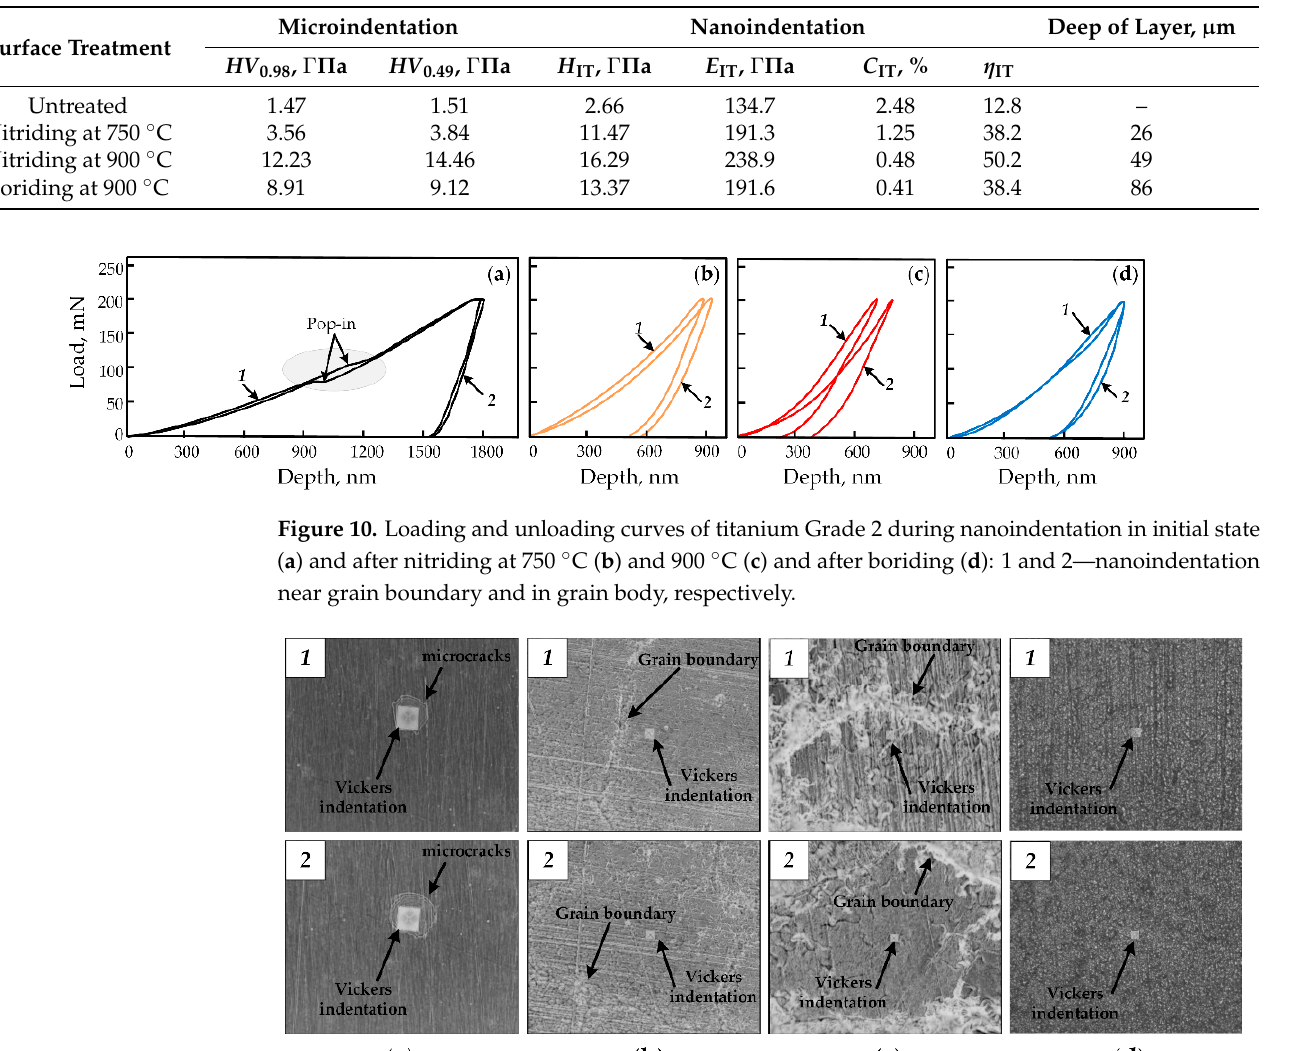
Table 4. Results of durometric analysis of titanium Grade 2 after surface treatment.